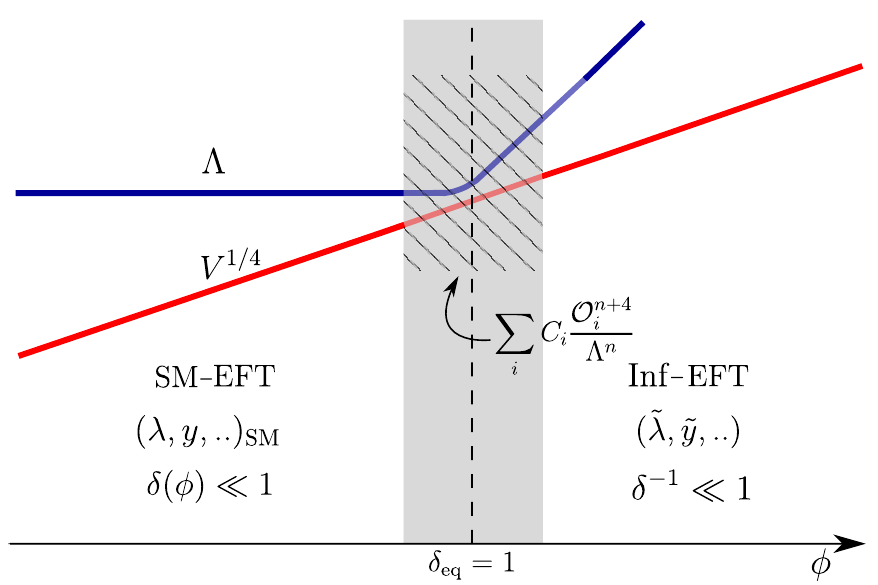
Figure 1 . Overview of the renormalization group (cid:13)ow e(cid:11)ects on the in(cid:13)ationary predictions. Shown is the typical energy of the potential V 1 = 4 (red) and the unitarity cuto(cid:11) (blue) as a function of the parameter (cid:14) = V= M 4 that distinguishes between the small (cid:12)eld ( (cid:14) (cid:28) 1) and large (cid:12)eld ( (cid:14) (cid:29) 1) region. In each regime an EFT can be constructed which is valid below the cuto(cid:11) scale, and which depends on a set of independent couplings that are matched at the boundary at (cid:14) = 1. In the mid (cid:12)eld region, indicated by the grey area, the EFT description breaks down, and the e(cid:11)ects of UV physics (parameterized by a tower of higher order operators suppressed by the cuto(cid:11) scale) can be considerable. We implement this by adding threshold corrections to the couplings at the matching scale. We calculalate the in(cid:13)ationary RGEs to subsequently run the couplings from the mid-(cid:12)eld to the in(cid:13)ationary scale (cid:14) ? , where we calculate n s and r and analyse the e(cid:11)ects of the threshold